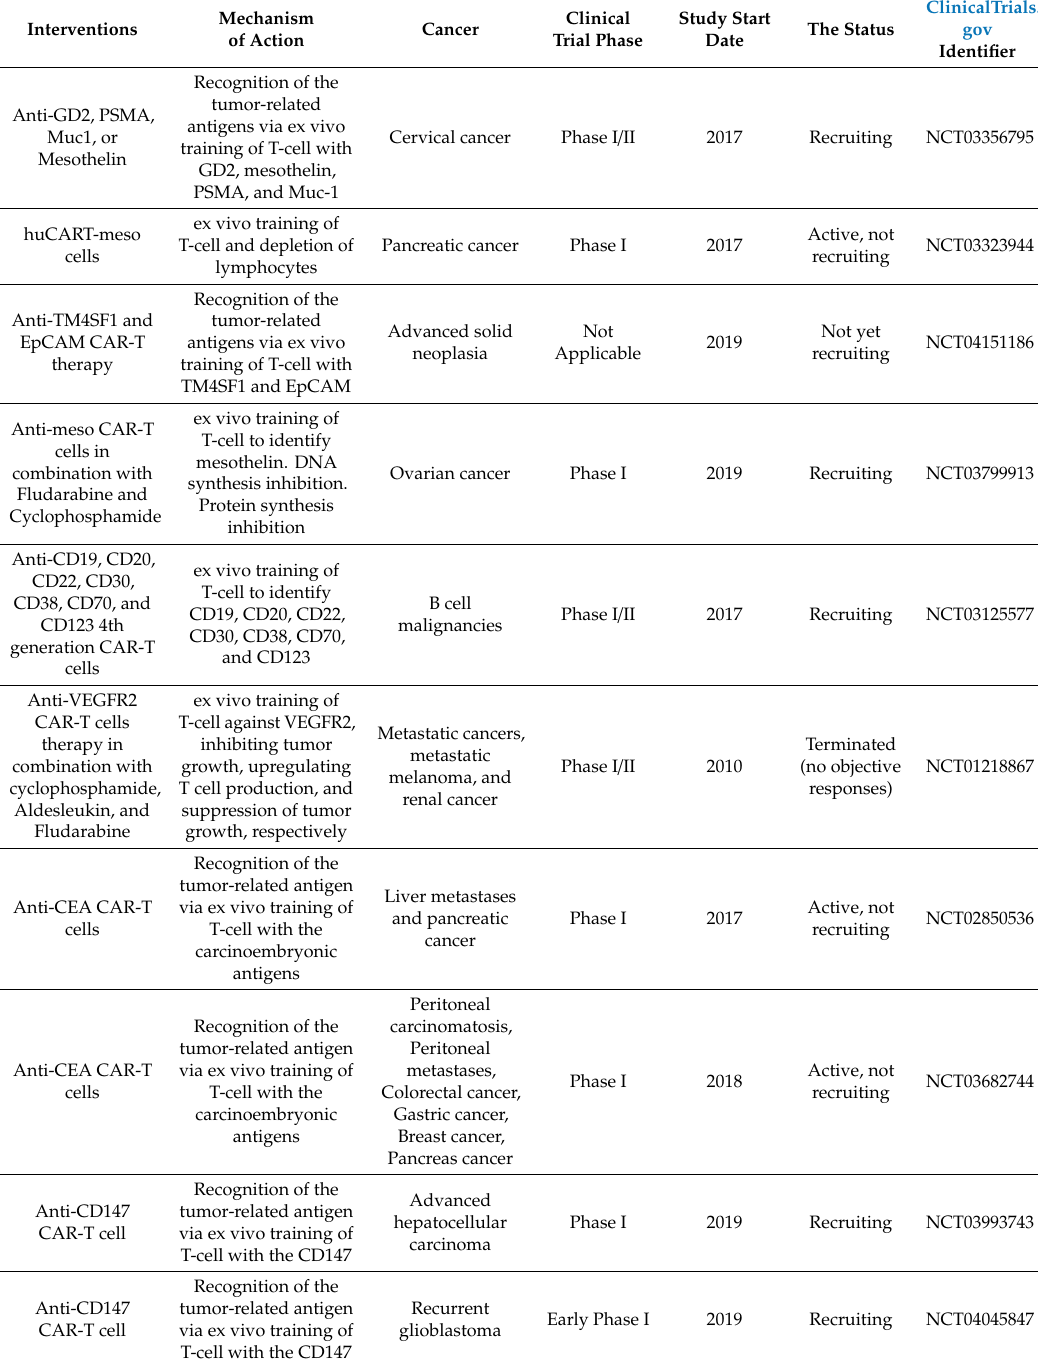
Table 3. Clinical trials regarding CAR-T